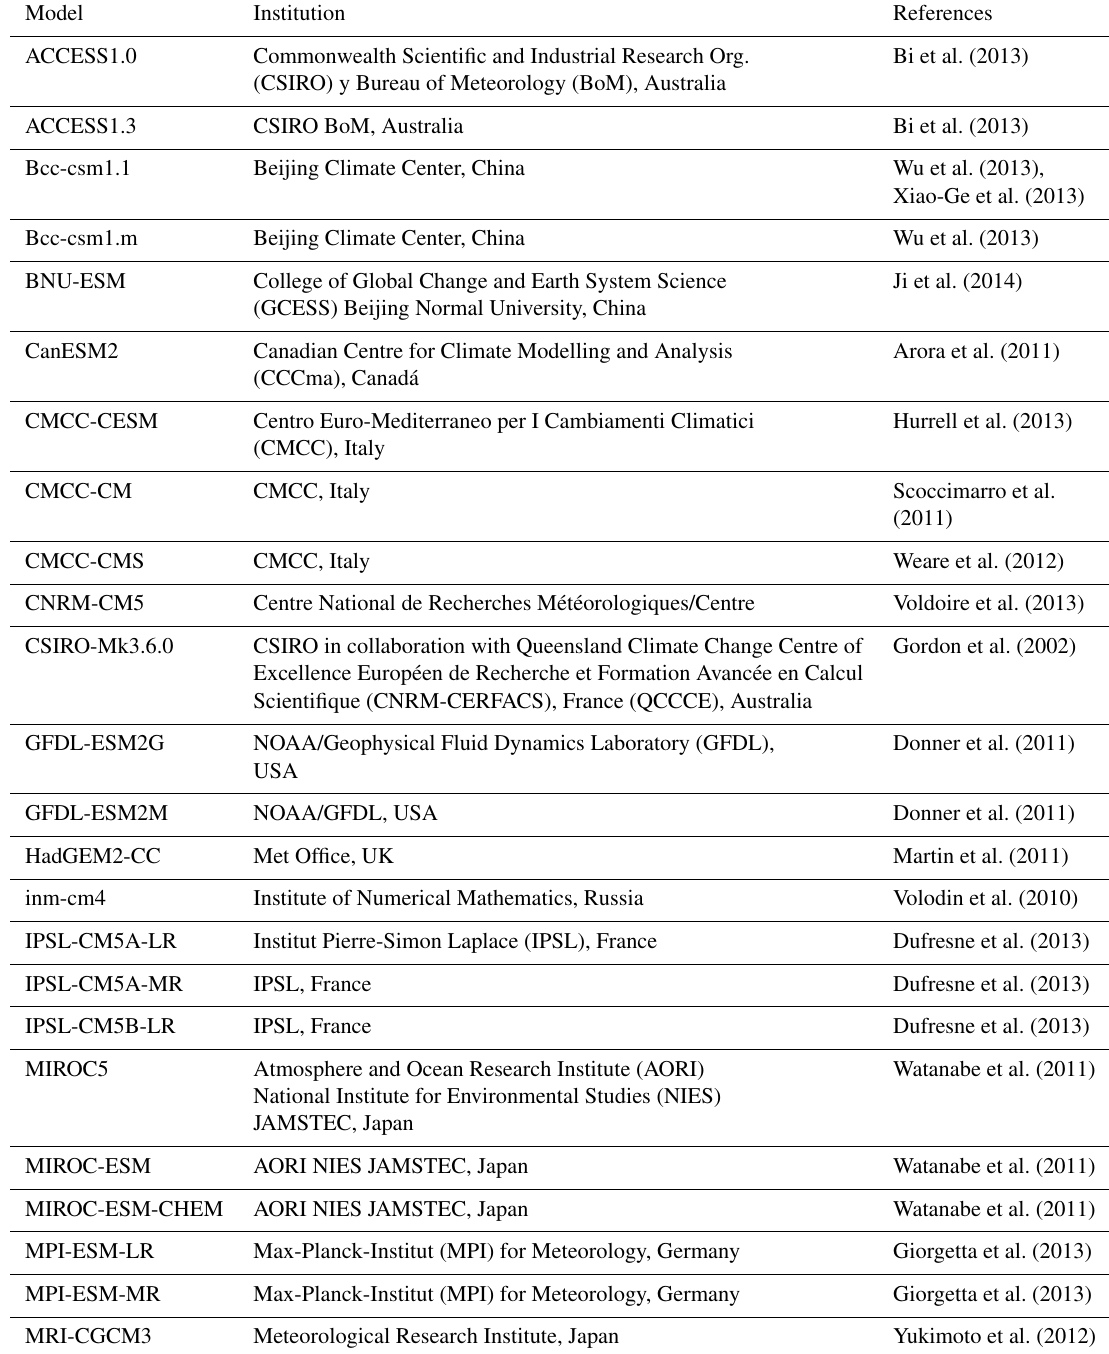
Table 2. List of CMIP5 models used in the CLIMPY Regionalized Projections by AEMET.